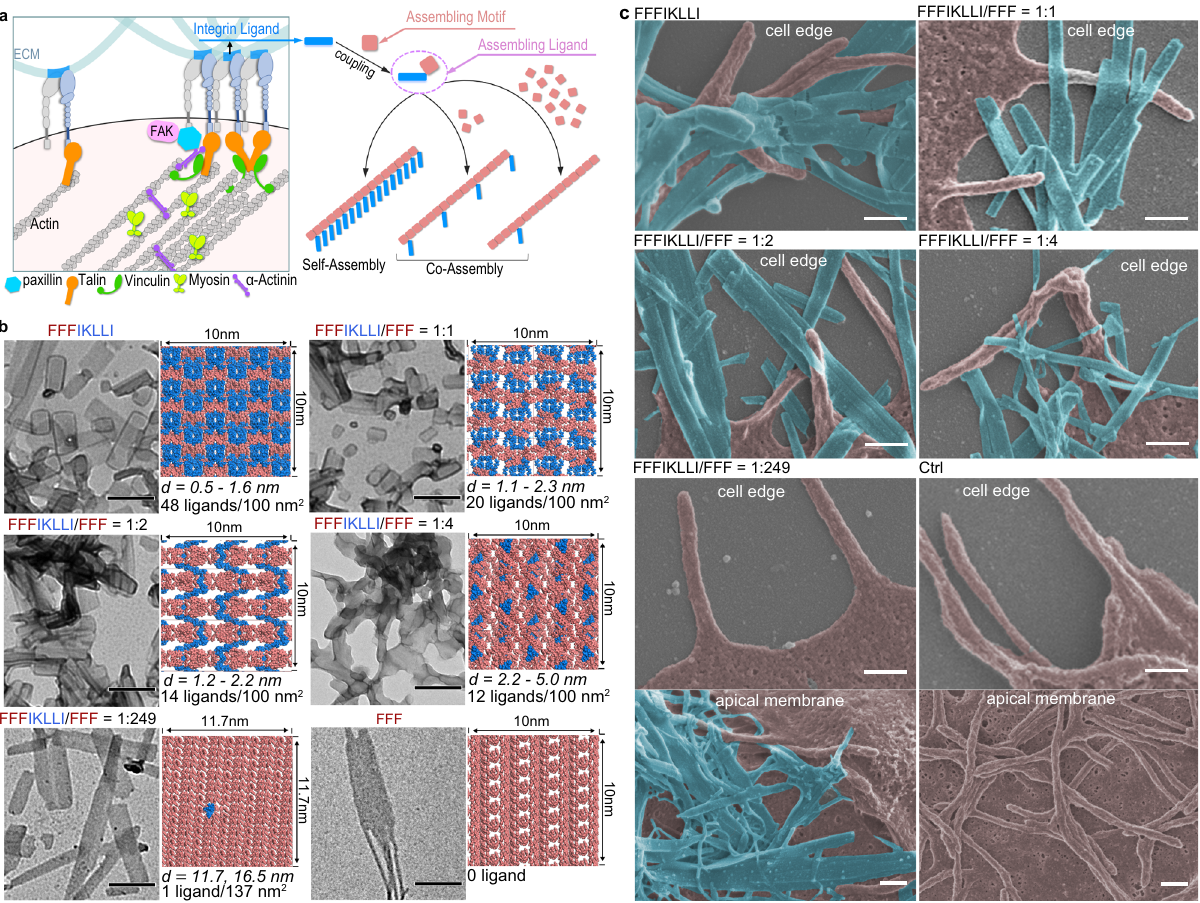
Fig. 1 | Engineering integrin ligand assembly to control ligand presentation. a Schematic illustration of precise control of integrin ligand presentation on nano fi laments via peptide assembly. b TEM images of nano fi laments obtained via molecular self-assembly and co-assembly of FFFIKLLI (100 μ M) and FFF at various ratios, and the estimated molecular packing structures. IKLLI motif is presented in